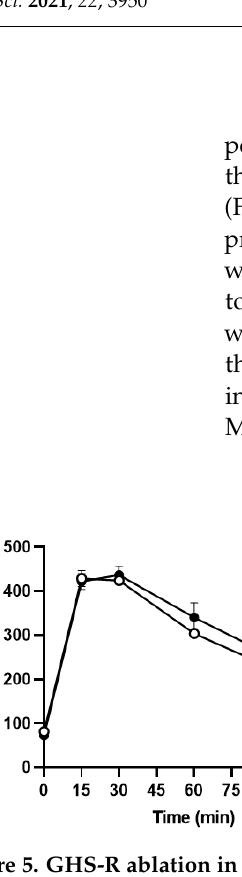
Figure 5. GHS-R ablation in β cells altered insulin secretion and sensitivity . ( A , B ) Three-point-five-month-old Ghsr f/f and MIP-CreER;Ghsr f/f mice were fasted overnight, and a glucose tolerance test was performed. Glucose and insulin were measured. n = 5. ( C ) Seven-month-old mice were fasted for 6 h and an insulin tolerance test was performed. n = 4. * p < 0.05 Ghsr f/f vs. MIP-Cre/ERT;Ghsr f/f .